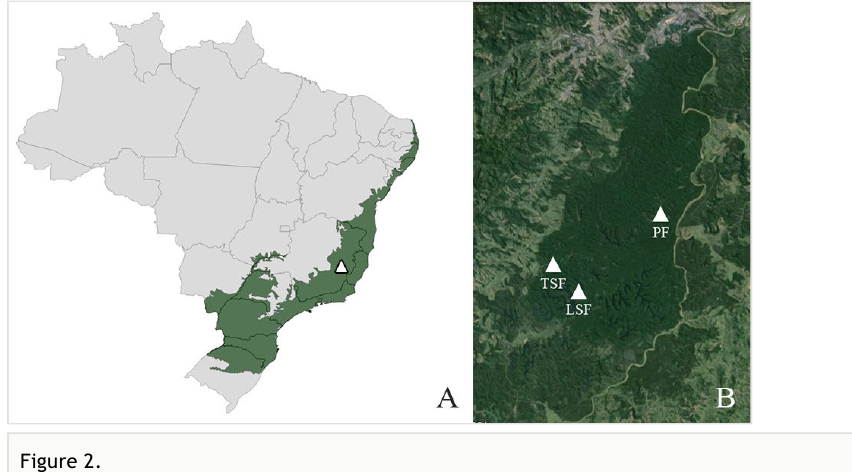
Figure 2. Map showing the study area. A, Brazilian Atlantic Forest (green) with the location of Parque Estadual do Rio Doce highlighted (white triangle). B, Map of the study area, with the three sampled sites highlighted. PF , primary forest; TSF , tall secondary forest; LSF , low secondary